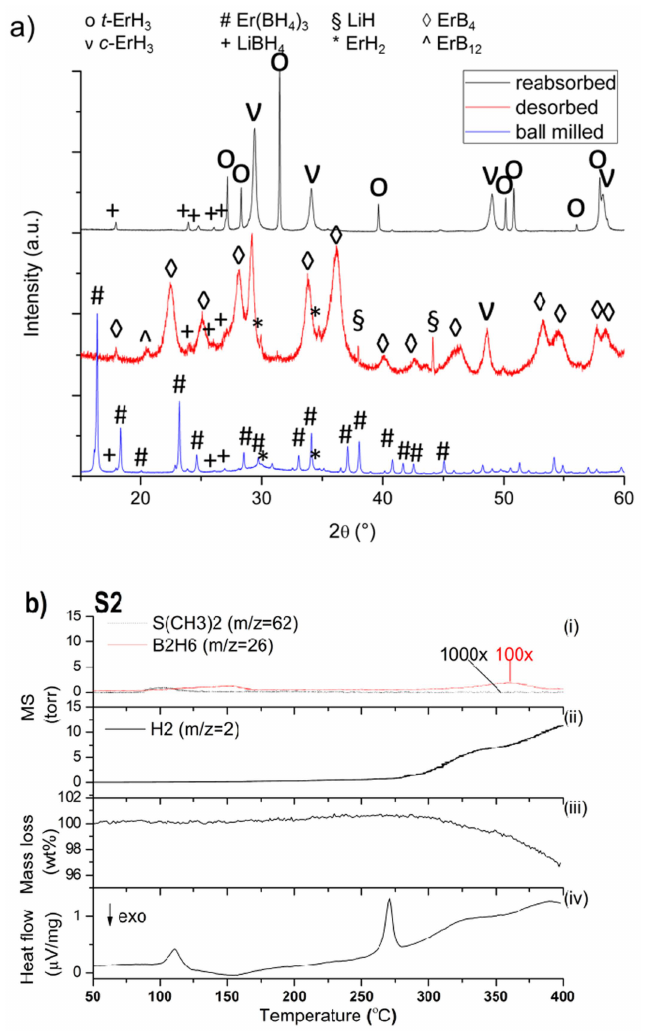
Figure 3. ( a ) Ex situ PXD data of S2 at RT showing one absorption-desorption cycle with ball milled (bottom), desorbed (middle), and reabsorbed (top) composite. λ = 1.54056 Å; ( b ) MS-TG-DSC of ball milled S2 from RT to 400 ◦ C (heating rate 5 ◦ C · min − 1 ) showing: (i) release of S(CH 3 ) 2 and B 2 H 6 ; (ii) H 2 ; (iii) TG data; and (iv) DSC